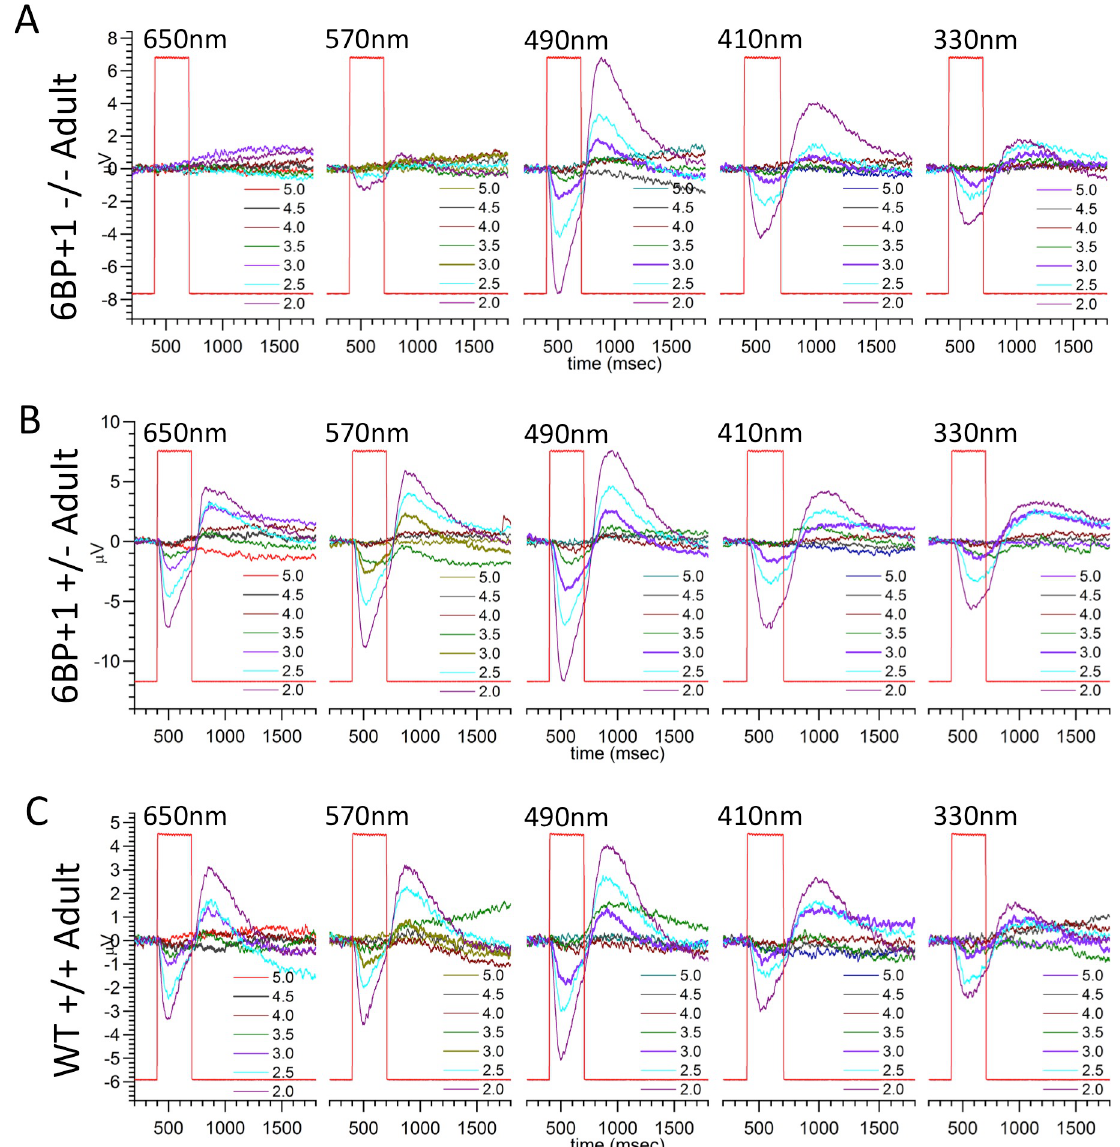
Fig 14. Adult PIII ERG response plots. (A) 6BP+1 mutant adults (7 eyecups, 12 datasets) did not respond to 650 nm, but did respond to the maximum brightness level of 570 nm. (B) Heterozygotes respond to every wavelength (6 eyecups, 9 datasets). (C) Wild types respond to all wavelengths (7 eyecups, 11 datasets). Only half of a dataset is shown for A, B, and